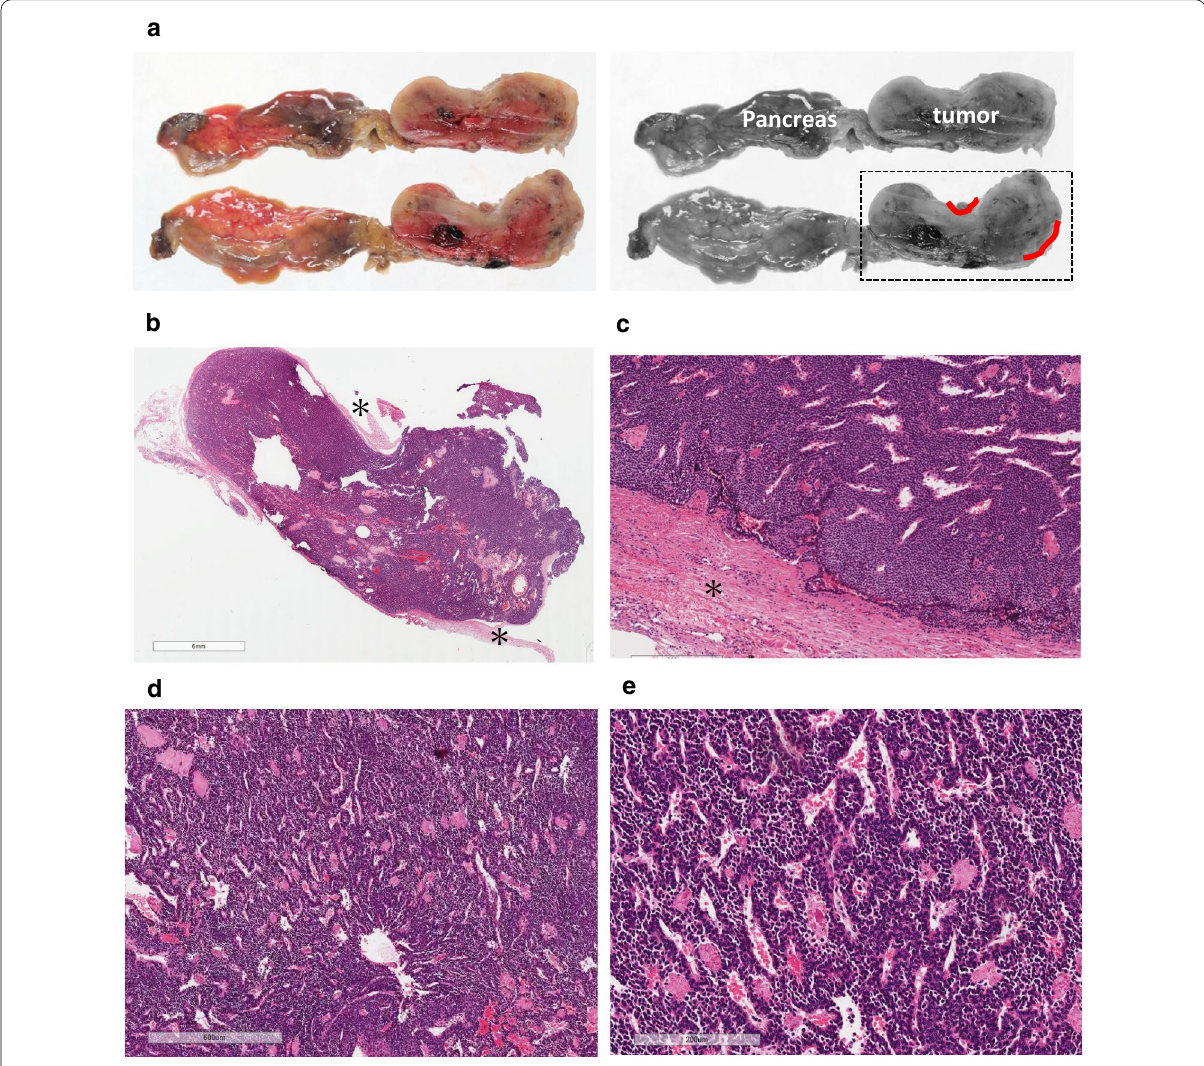
Fig. 5 Histopathology. a Macroscopic findings of the tumor division surface after formalin fixation. The solid tumor arising from pancreas body invading the SMV wall (traced in red). An interrupted square shows the part shown in “b”. b , c , d , e Hematoxylin–eosin (HE) staining of the resected specimen revealed solid proliferation of tumor cells with oval-shaped nuclei and scanty cytoplasm around the disorganized or slit-shaped vessels. Asterisks indicate the SMV wall in the